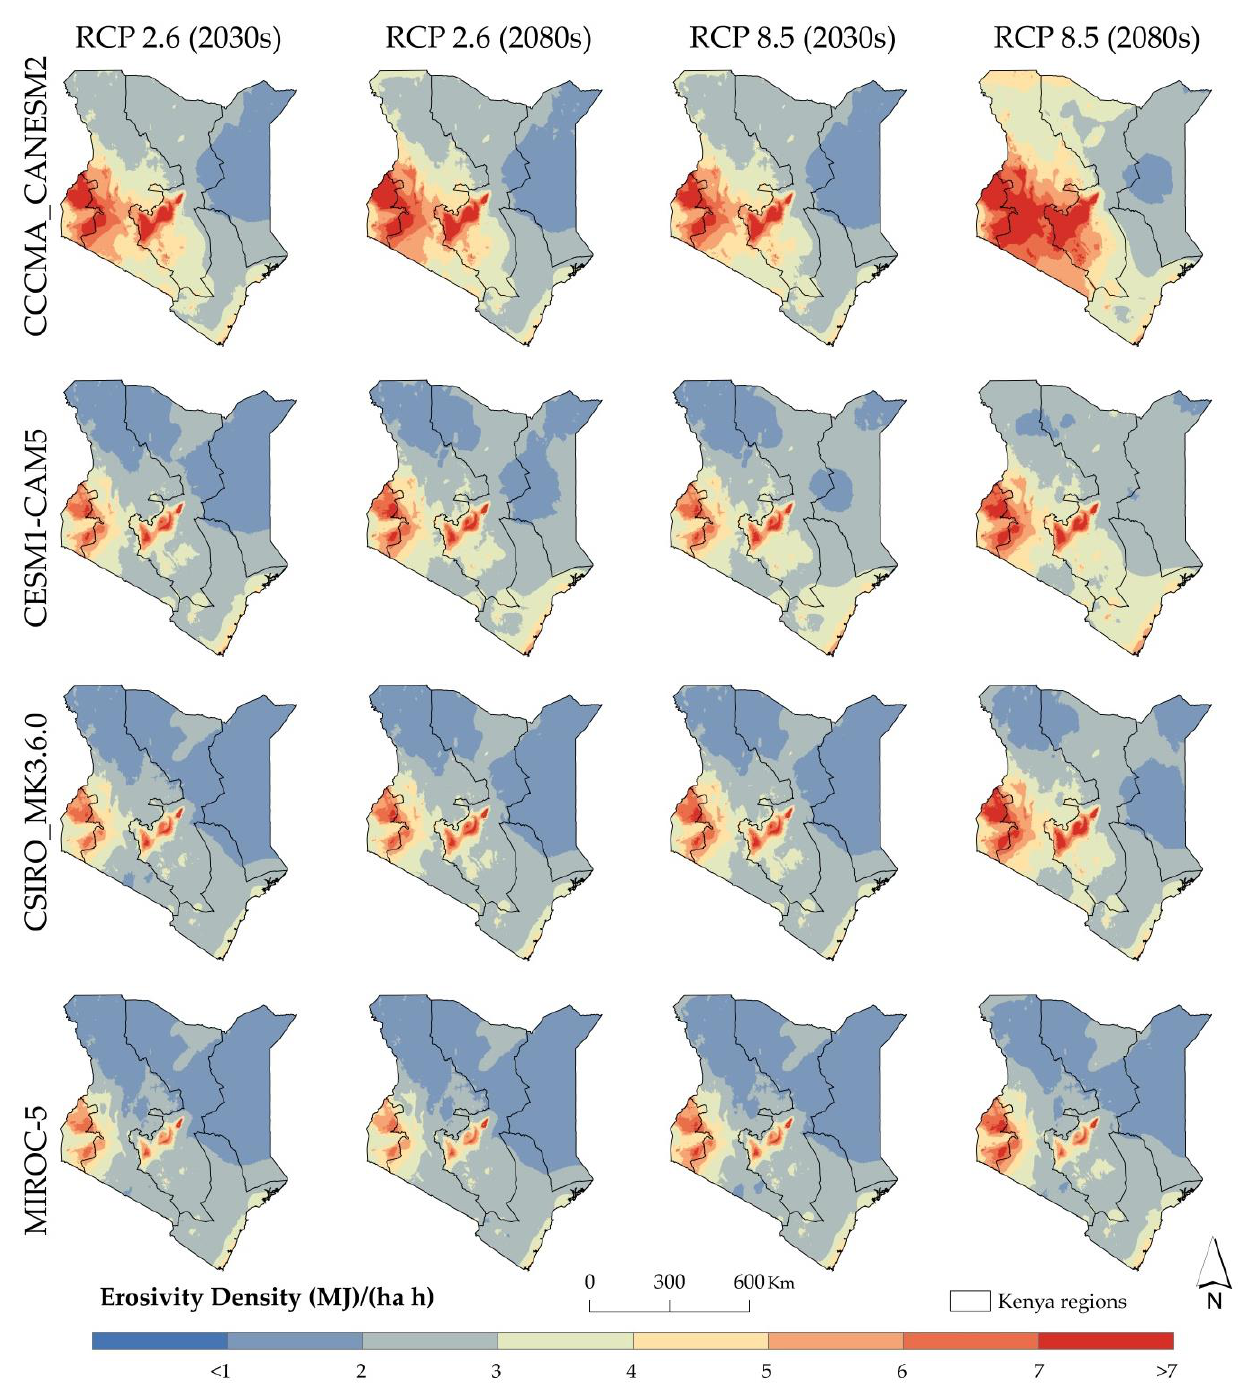
Figure 12. Erosivity density for the periods of the 2030s and 2080s under RCP 2.6 and 8.5 scenarios, driven by CCCMA_CANESM2, CESM1-CAM5, CSIRO_MK3.6.0 and MIROC-5 GCMs.